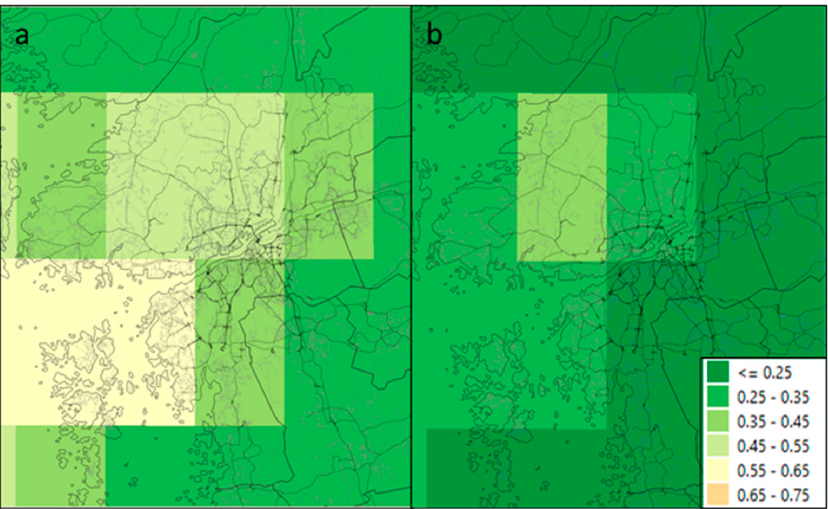
Figure 3. Exposure to PM 2.5 (µg/m 3 ) from shipping in the Baltic Sea in Gothenburg using a regional model: ( a ) high-sulfur; ( b ) low-sulfur.